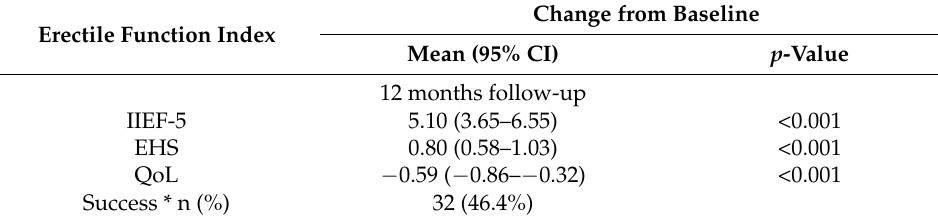
Table 2. Cont. Erectile Function